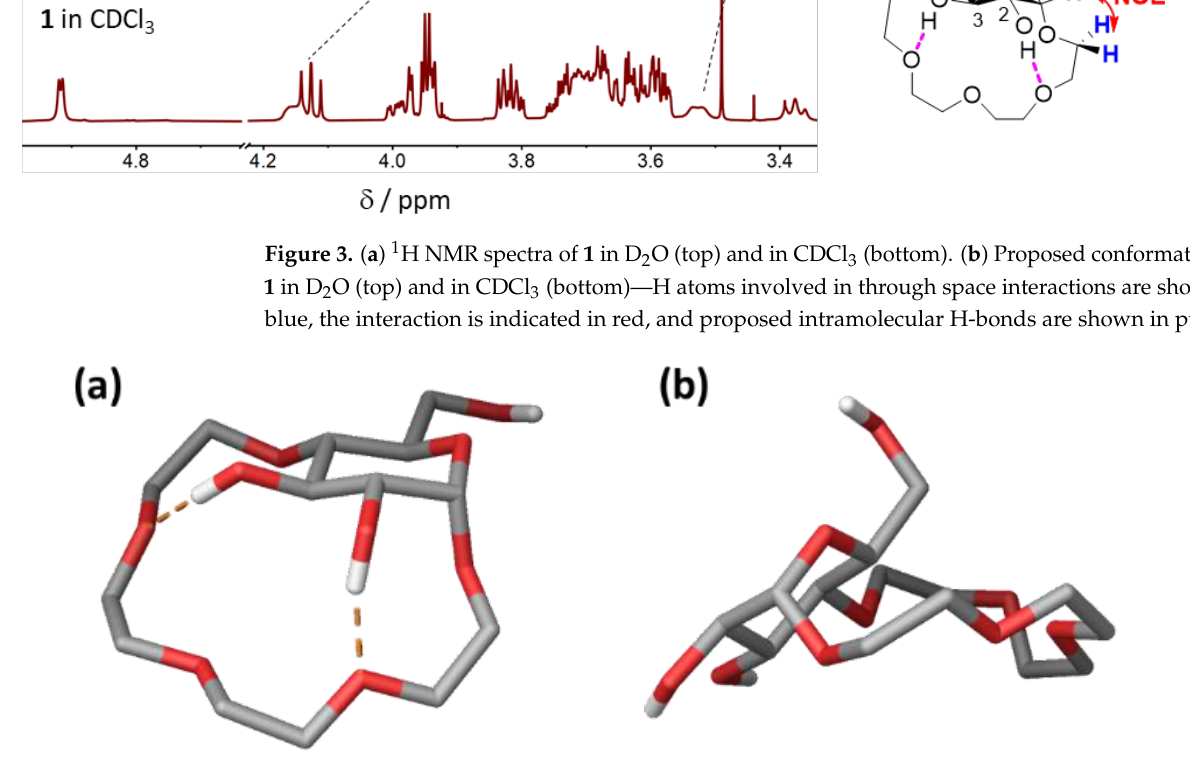
Figure 3. ( a ) 1 H NMR spectra of 1 in D 2 O (top) and in CDCl 3 (bottom). ( b ) Proposed conformation of 1 in D 2 O (top) and in CDCl 3 (bottom) — H atoms involved in through space interactions are shown in blue, the interaction is indicated in red, and proposed intramolecular H-bonds are shown in pur- ple.